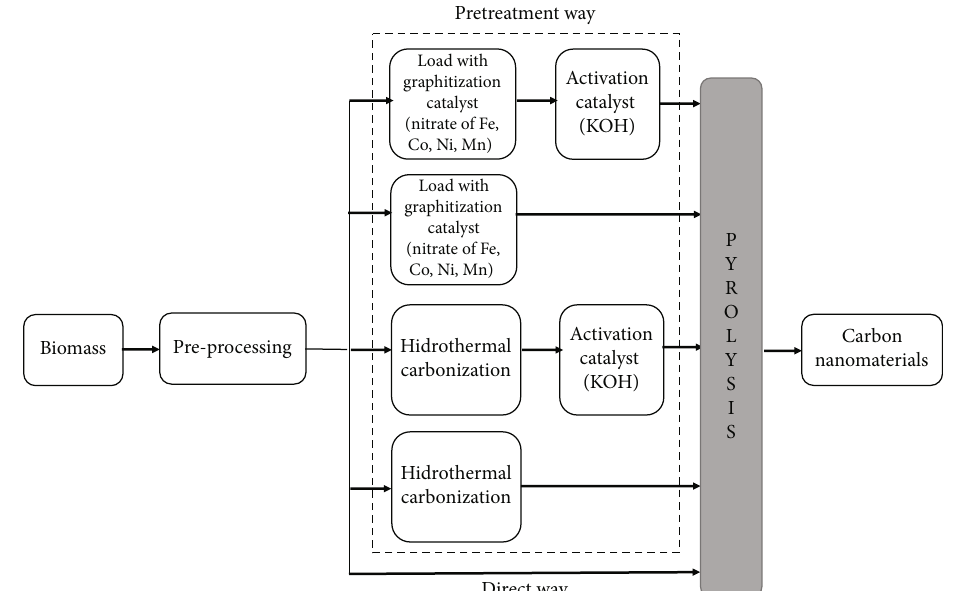
Figure 6: Preparation of carbon nanomaterials from biomasses